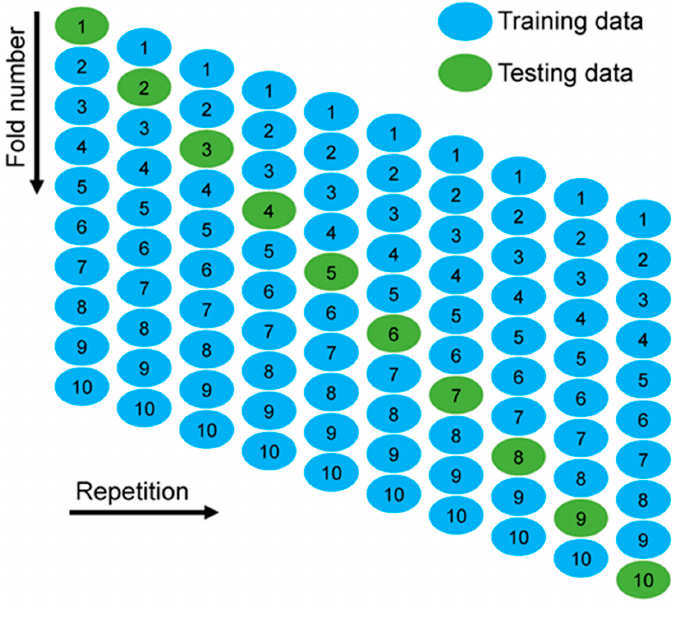
Figure 16. Statistical evaluations of the models used for this investigation [67]. Figure 17. Statistical evaluations of the models used for this investigation Table 2. Statistics derived from the employed models.